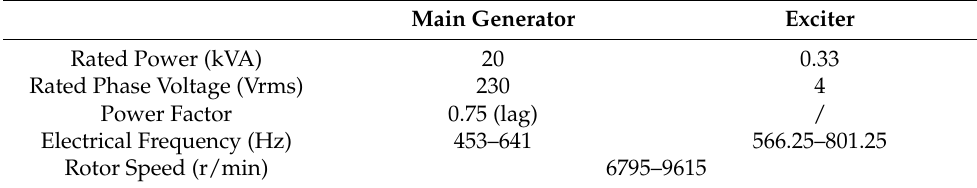
Table 1. Operation conditions of the